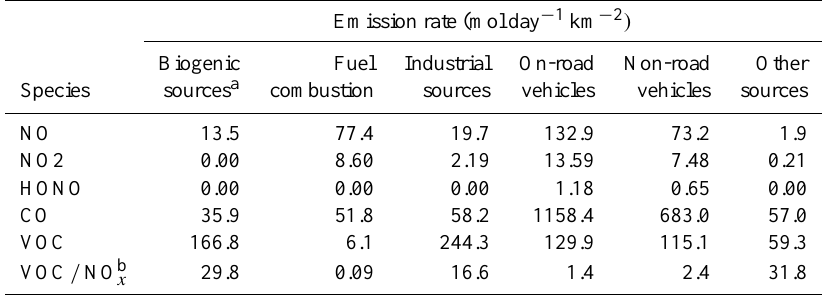
Table 1. Summary of daily emission rates used in the base-case simulation.